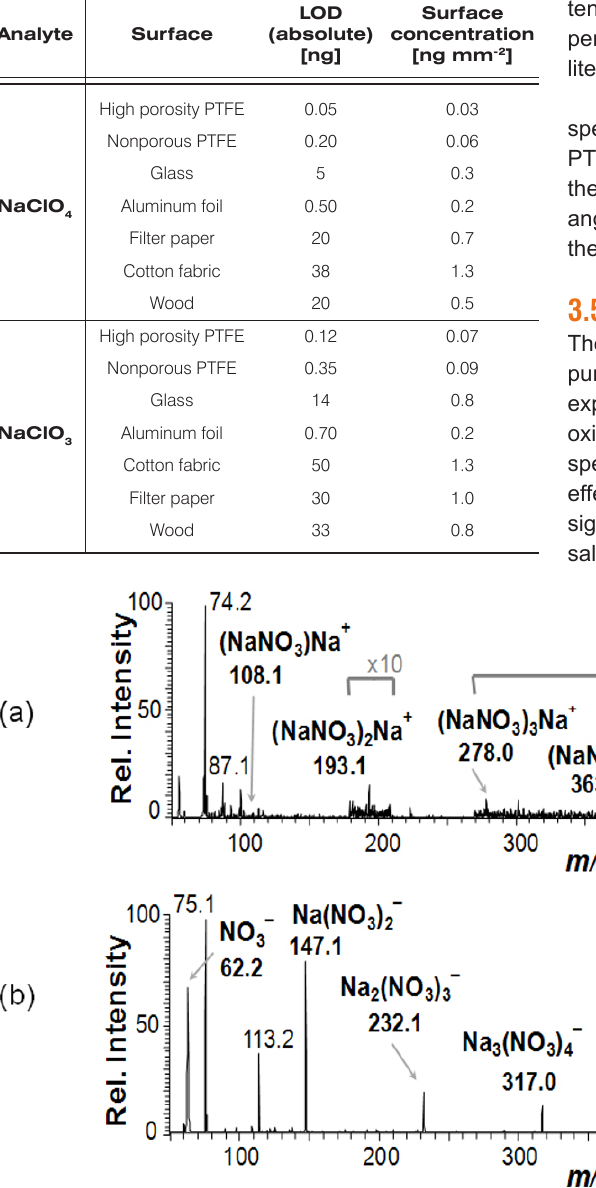
Table 2. Comparison of investigated